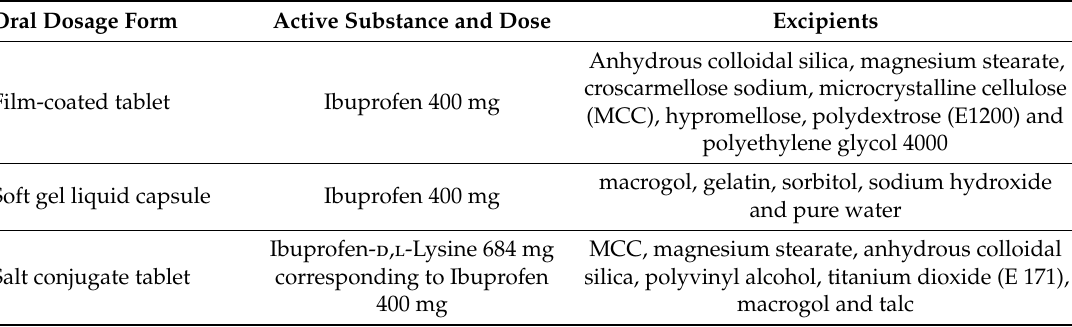
Table 1. Ibuprofen (IBU) commercial oral dosage